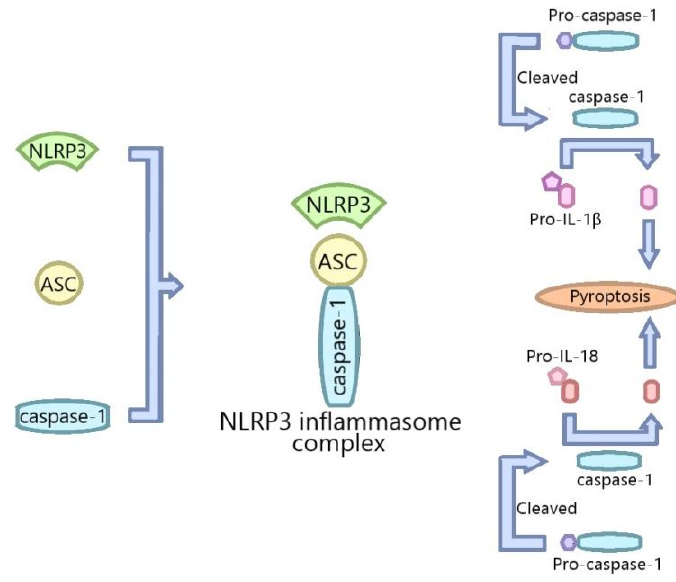
Figure 2. The formation of the NLRP3 inflammasome.